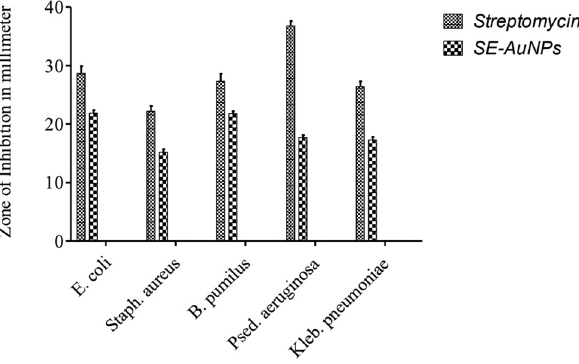
Figure 12: Antibacterial potency of SE - mediated AuNPs in compar - ison with the standard streptomycin against di ff erent pathogenic fungal